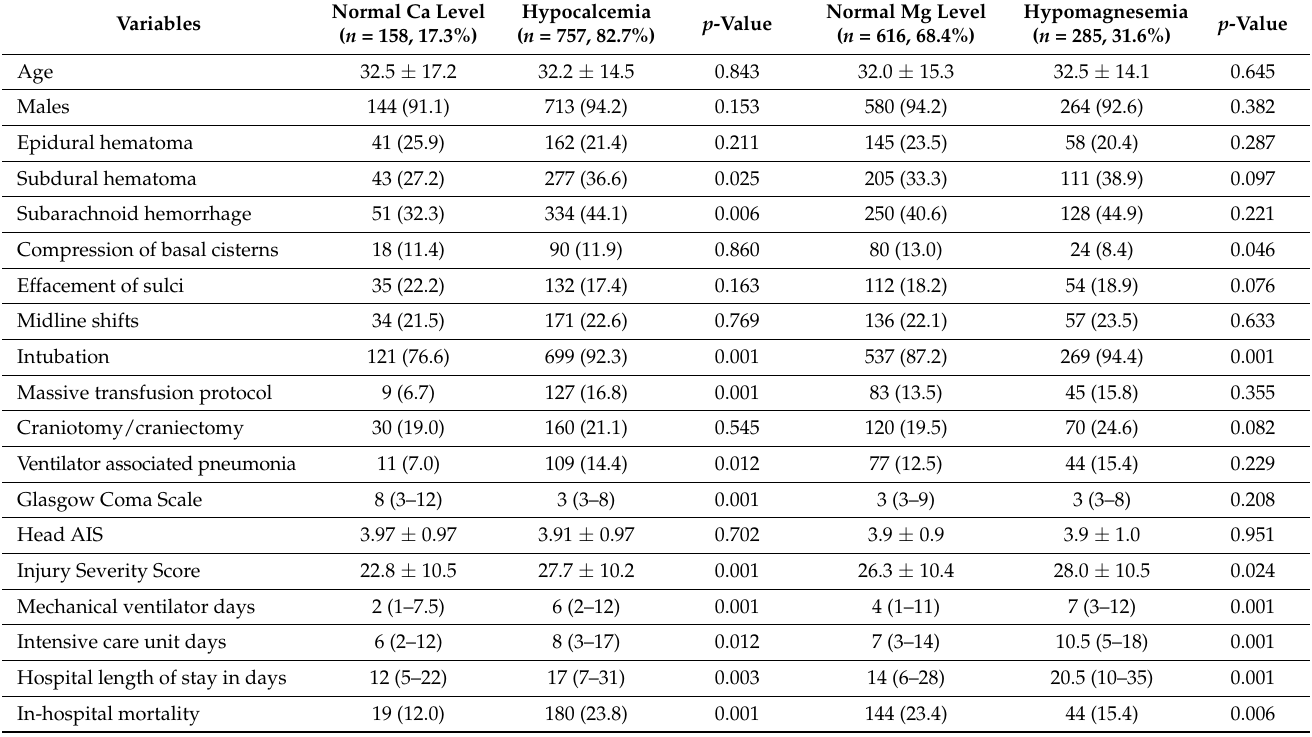
Table 4. Comparative analysis between serum hypo levels and normal levels for calcium (N = 915) * and magnesium (N = 901) ** at admission in patients with traumatic brain injuries.